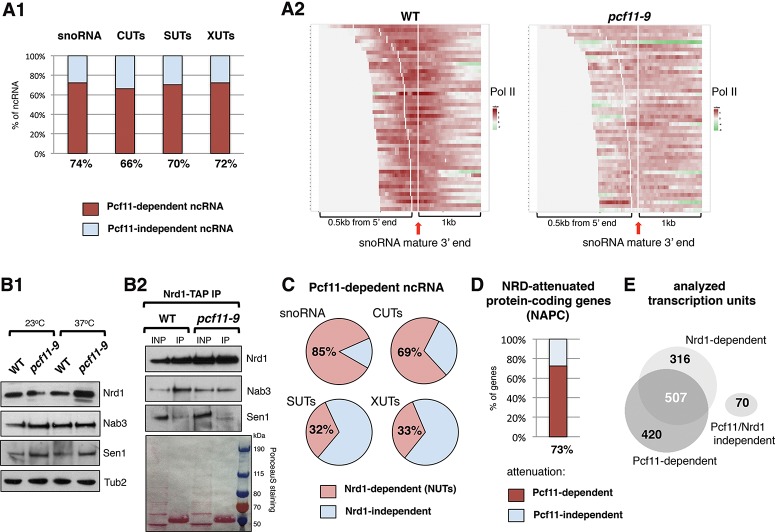
Pcf11 terminates the majority of ncRNA. (A1) Fraction of snoRNA, CUTs, SUTs, and XUTs that requires Pcf11 for transcription termination. (A2) Heat maps showing Pol II levels up to 0.5 kb 5′ and 1 kb 3′ of snoRNA mature 3′ ends in wild type (WT) and pcf11-9. Signals are aligned relative to snoRNA mature 3′ ends (vertical white line marked by red arrow). The white spacer for individual snoRNA marks the 5′ end. (B1) Western blot showing levels of NRD components in pcf11-19; anti-Nrd1, anti-Nab3, and anti-HA antibodies were used to detect Nrd1, Nab3, and Sen1-HA, respectively. (B2) Western blot analysis of fractions coprecipitated with Nrd1-TAP from wild type and pcf11-9. PAP antibody was used to detect Nrd1-TAP, while anti-Nab3 was used to detect Nab3, and anti-HA was used to detect Sen1-HA. (C) Overlap of Pcf11-dependent ncRNA with annotated NUTs. (D) Fraction of NAPC genes, which require Pcf11 for premature transcription termination. (E) Venn diagram presenting the overlap between Pcf11- and Nrd1-dependent transcription units.